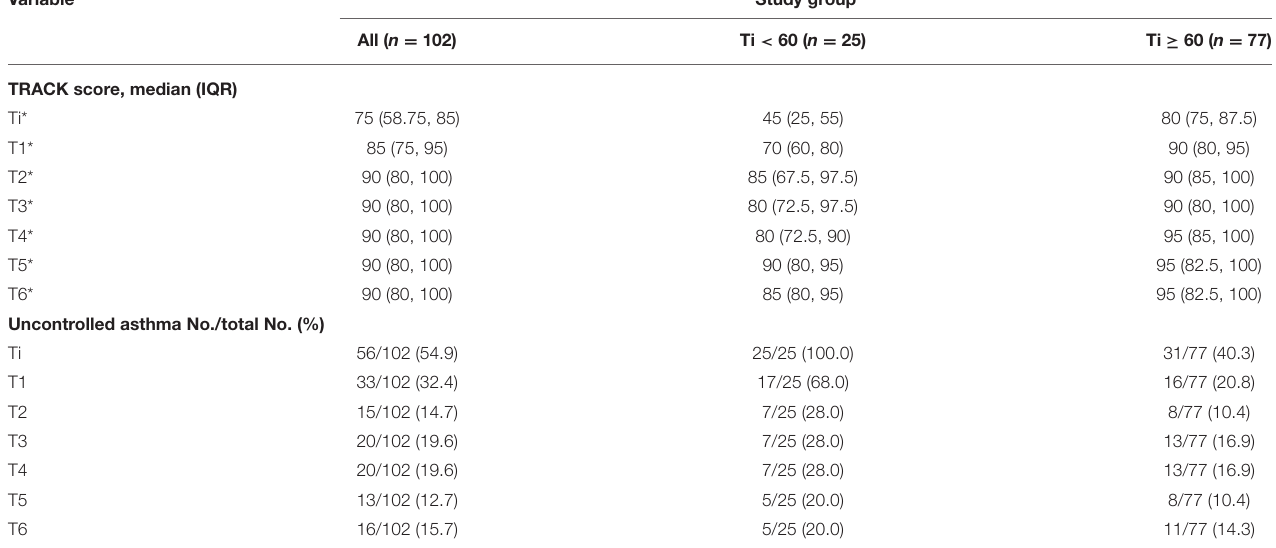
TABLE 2 | Description statistics of outcome